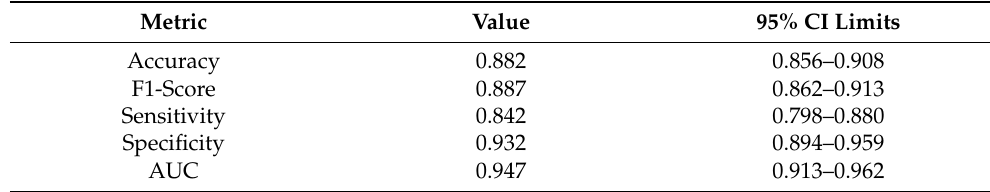
Table 1. Metrics for classification of AAp.